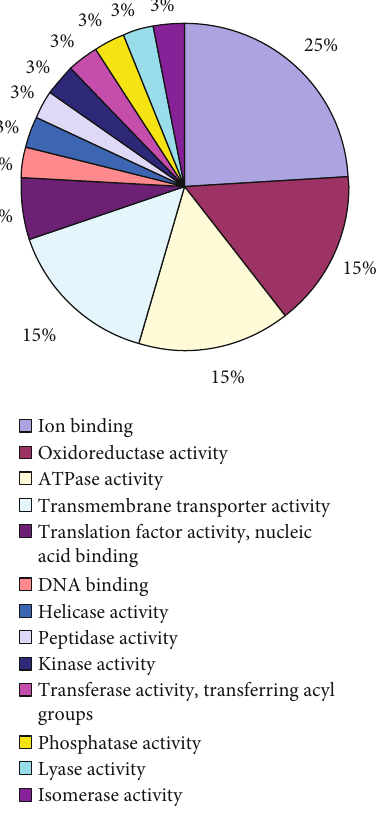
Figure 4: The functional groups of the proteins of Coriolus versicolor in response to methanol extracts from the xylem of Cinnamomum